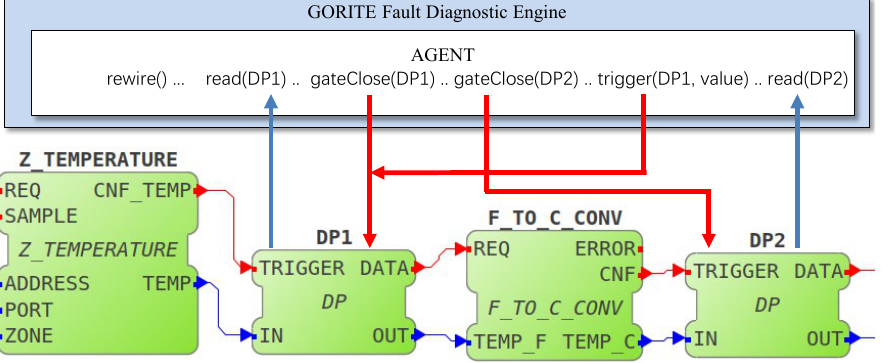
Figure 9. Capturing and triggering Diagnostic